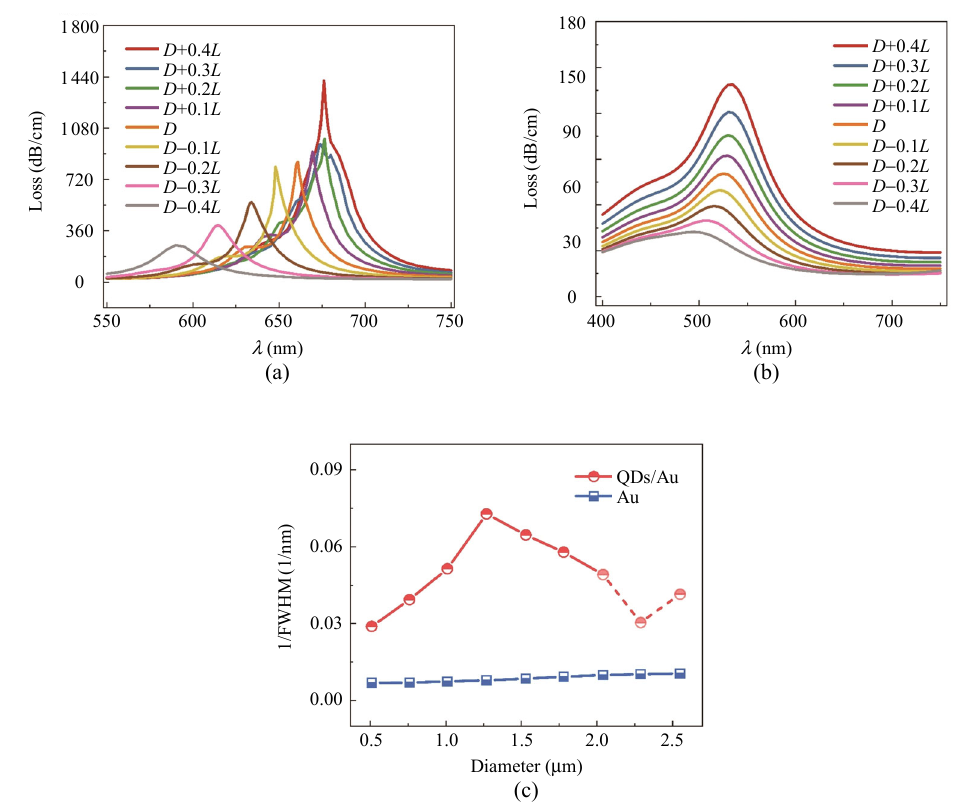
Fig. 4 Loss spectra for the QDs/Au sensors (a) and Au sensors (b) with different diameters for the central holes, and (c) results of 1/FWHM extracted from (a) and (b).